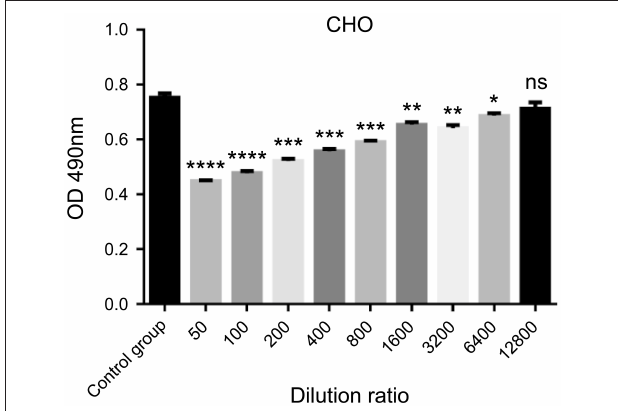
FIGURE 3 | Cell proliferation and cytotoxicity test of Perinereis aibuhitensis hemoglobin. Results are expressed as means ± SEM. **** p < 0.0001; *** p < 0.001; ** p < 0.01; * p < 0.05; ns, non-significant. Statistical analysis was performed using the Student’s t -test and the control group was used for